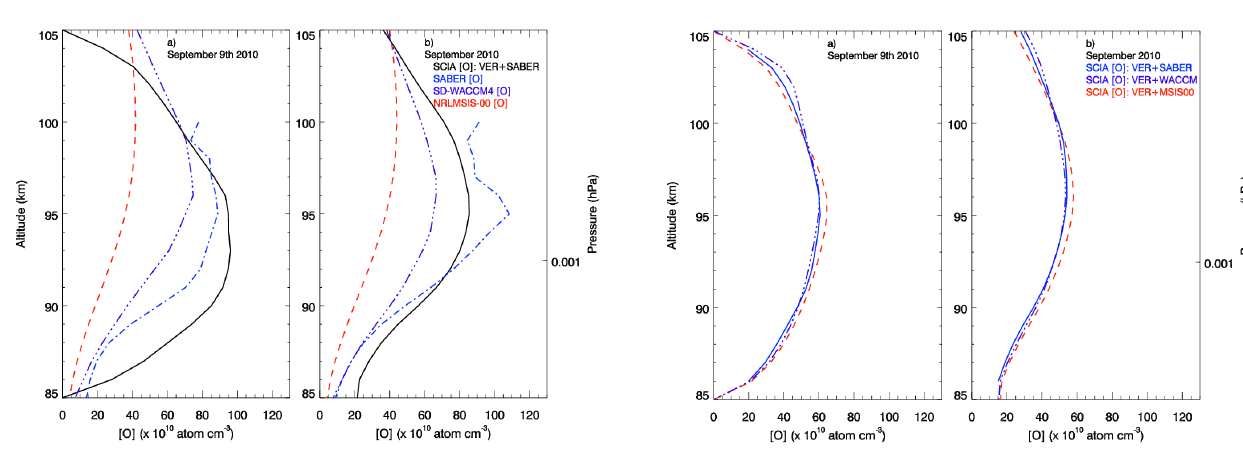
Figure 10. Sample daily (a) and monthly (b) averaged atomic oxy- gen concentration profiles ([O cubic ] – blue solid, [O cubic ] – ]) compared with SABER WACCM4 SABER violet dash-dotted, [O cubic ] – red dashed) according to the cubic MSIS00 equation (McDade et al., 1986) for different sources of background atmospheric profiles and for the 20–25 ◦ N latitude range.